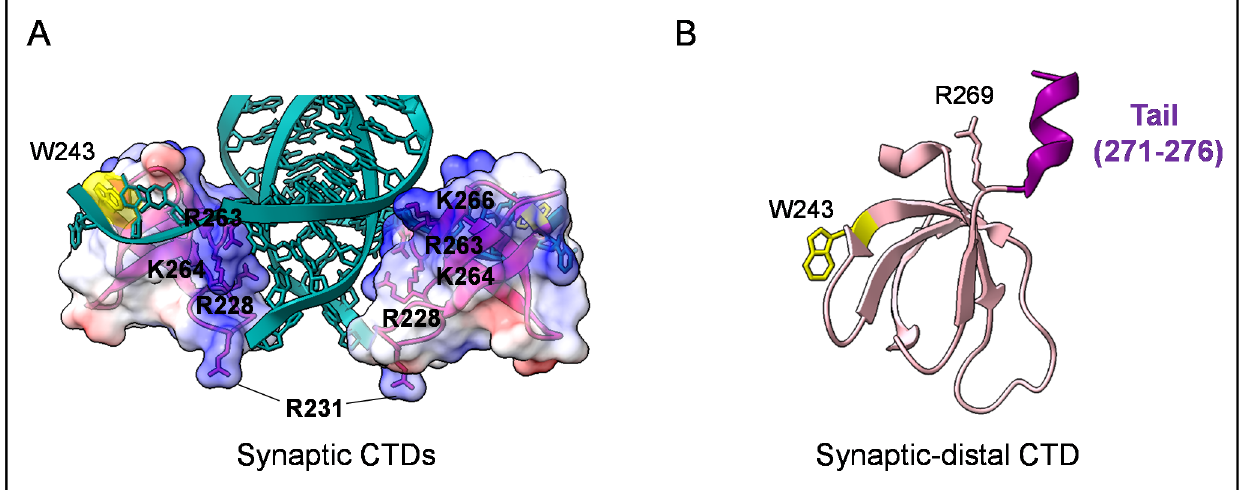
Figure 5. Interaction of synaptic CTDs with DNA and structure of synaptic––distal CTD. ( A ). Synaptic CTDs within CSC structure (PDB: 6PUT, [23]). Electrostatic surfaces show the position of the basic patch oriented towards the vDNA (residues are labelled and indicated with lines, W243 is highlighted in yellow). Of particular interest, R231 is oriented on the opposite side of the vDNA and towards the cleft, where in the next step of integration pathway, the cleaved tDNA will establish the TCC and STC conformations. This orientation is consistent with the 5U1C structure of the HIV– -1 STC, where R231 is a specific contact with a tDNA base [23,24]. ( B ). Cartoon representation of synaptic–distal CTD (SD) within CSC structure (other IN domains and vDNA are not shown); it importantly shows the most complete version of the C–-terminal tail (until A276) folding into a helical structure (in purple) (PDB: 6PUT, [23]).